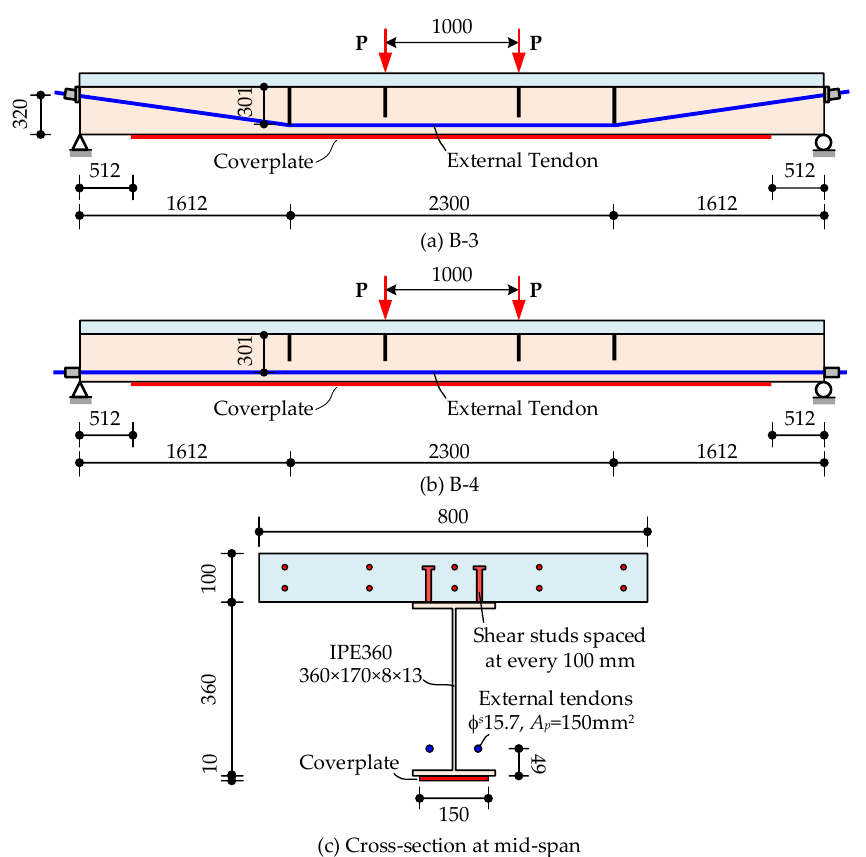
Figure 13. Structural details of specimens B3 and B4.